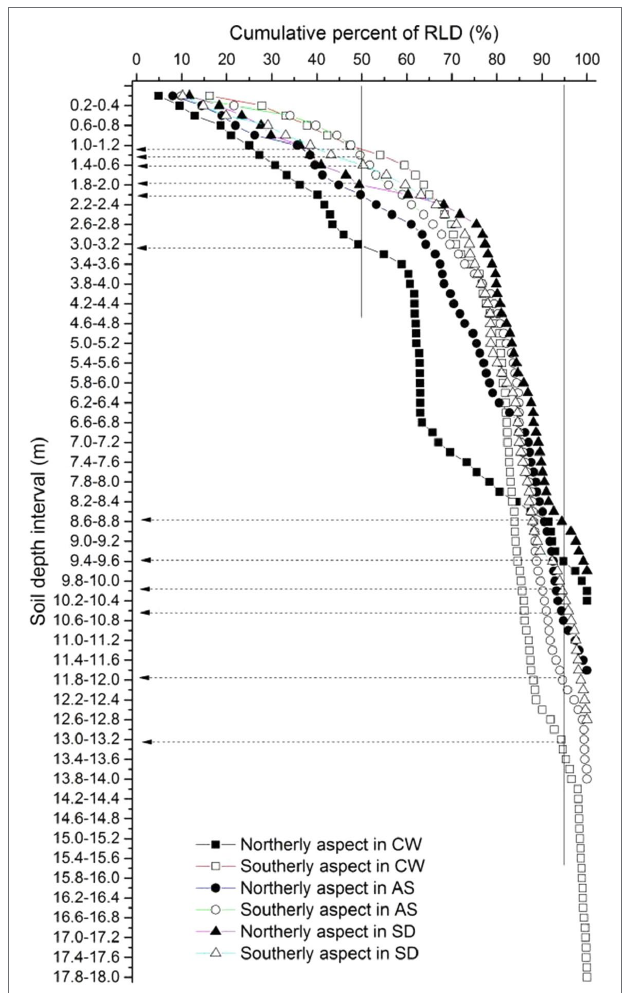
FIGURE 3 | Cumulative percentages of fine root length density down to the root front with soil depth. Solid lines denote the 50 and 95% total root length densities. Dashed lines are the corresponding soil depths above which 50 and 95% of the total root length densities are located. Solid and empty rectangles, circles, and triangles represent northerly and southerly aspects at the sites Changwu, Ansai, and Suide, respectively.